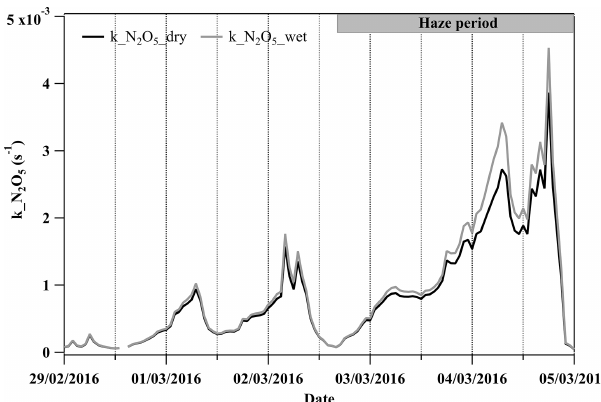
Figure 2. The time series of the condensational loss rate of N 2 O 5 (k_N 2 O 5 ) with the calculation of the dry particle number size distri- bution (PNSD) and wet PNSD during 29 February to 5 March